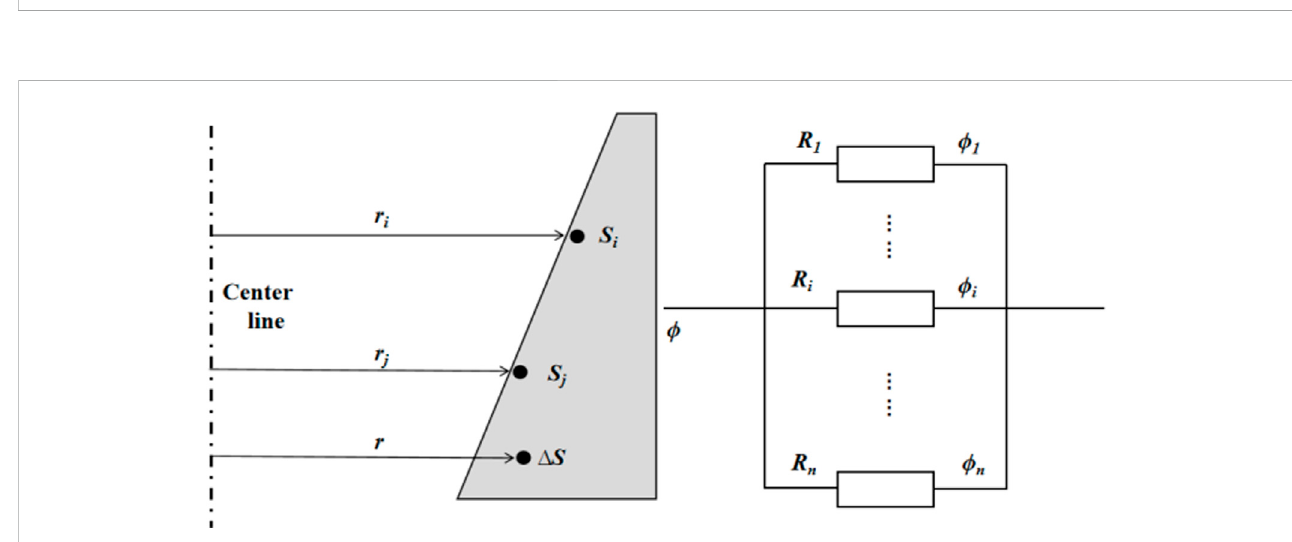
FIGURE 7 Equivalent magnetic circuit model of circumferential magnetization of bearing rings.